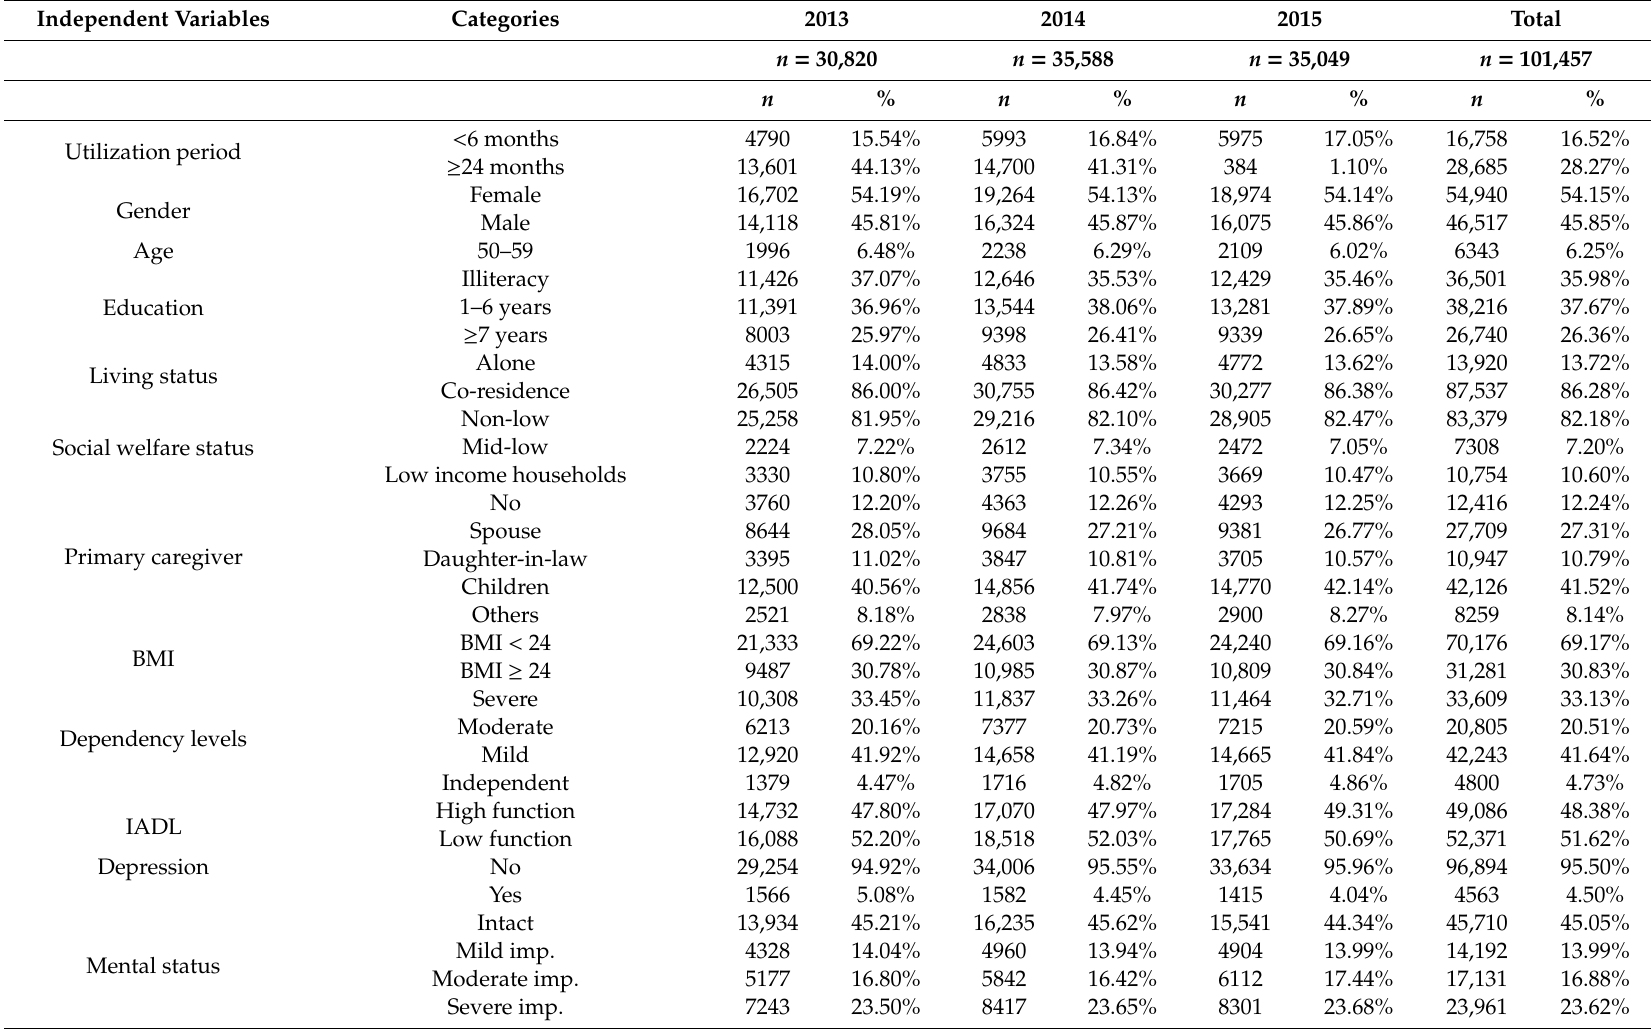
Table 1. Descriptive statistics of study samples who entered the HCBS formal system from 2013 to